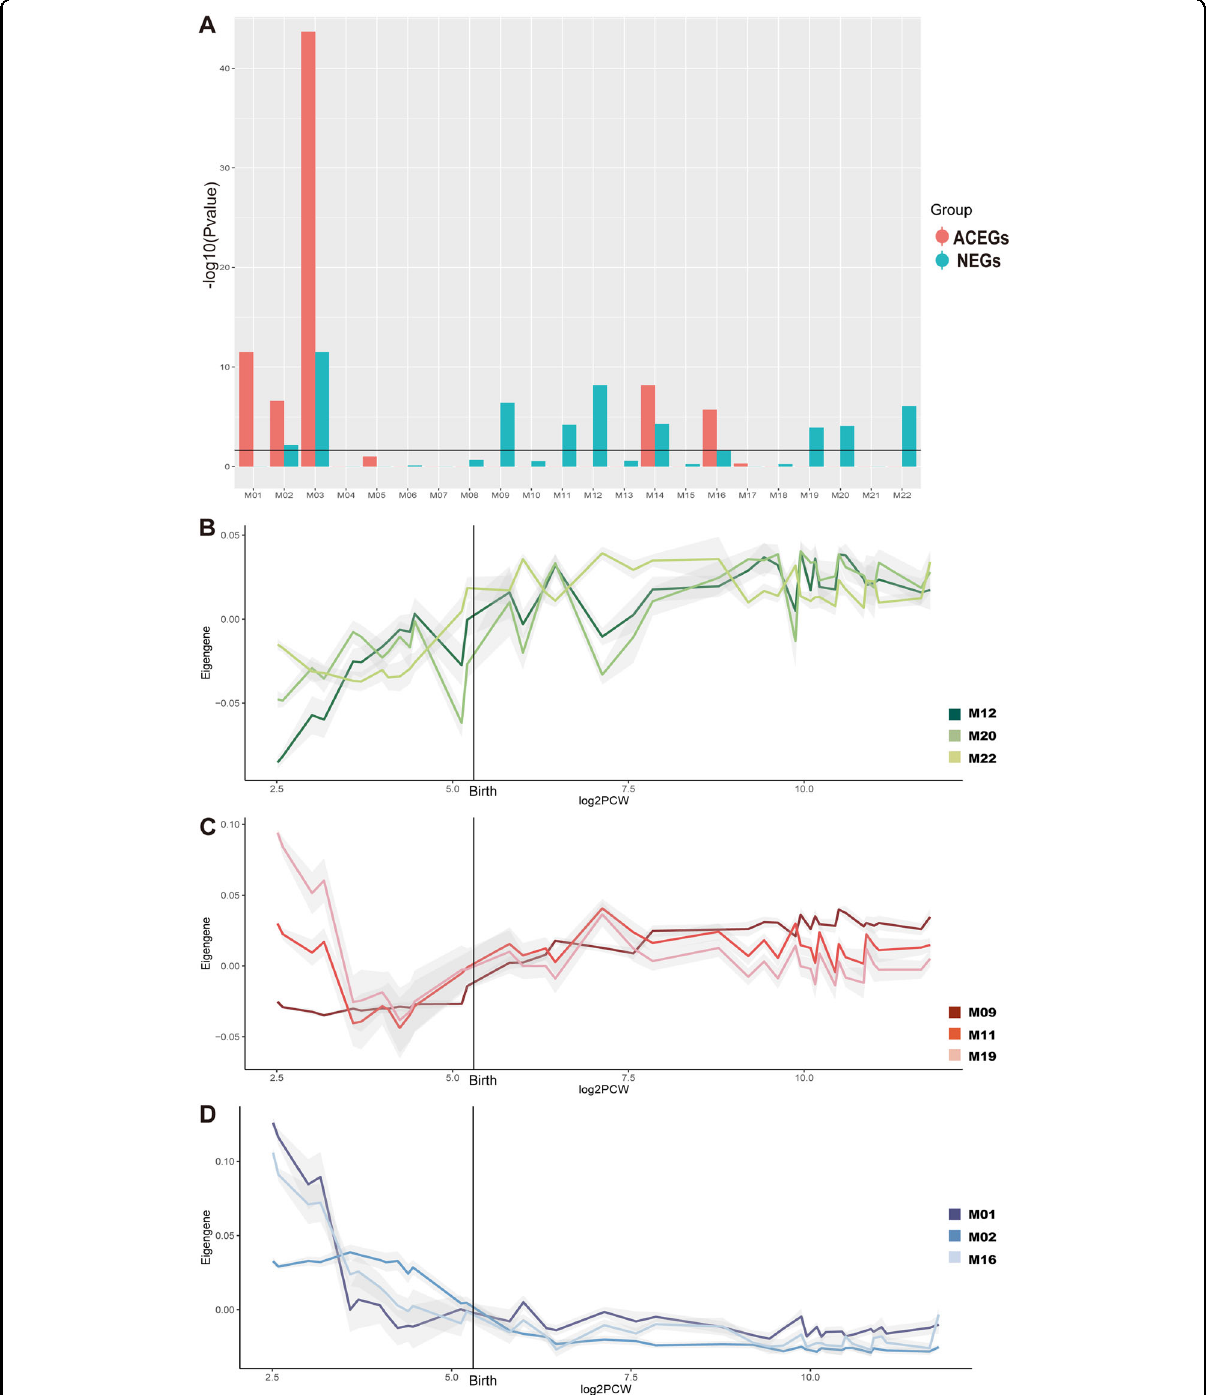
Fig. 3 Neuronal essential genes (NEGs) and Achilles Project-speci fi c essential genes (ACEGs) are enriched in different modules and show different expression patterns. a Module enrichment of NEGs and ACEGs. b Eigengene expression patterns of modules M12, M20, and M22. c Eigengene expression patterns of modules M11, M9, and M19. d Eigengene expression patterns of modules M01, M02, and